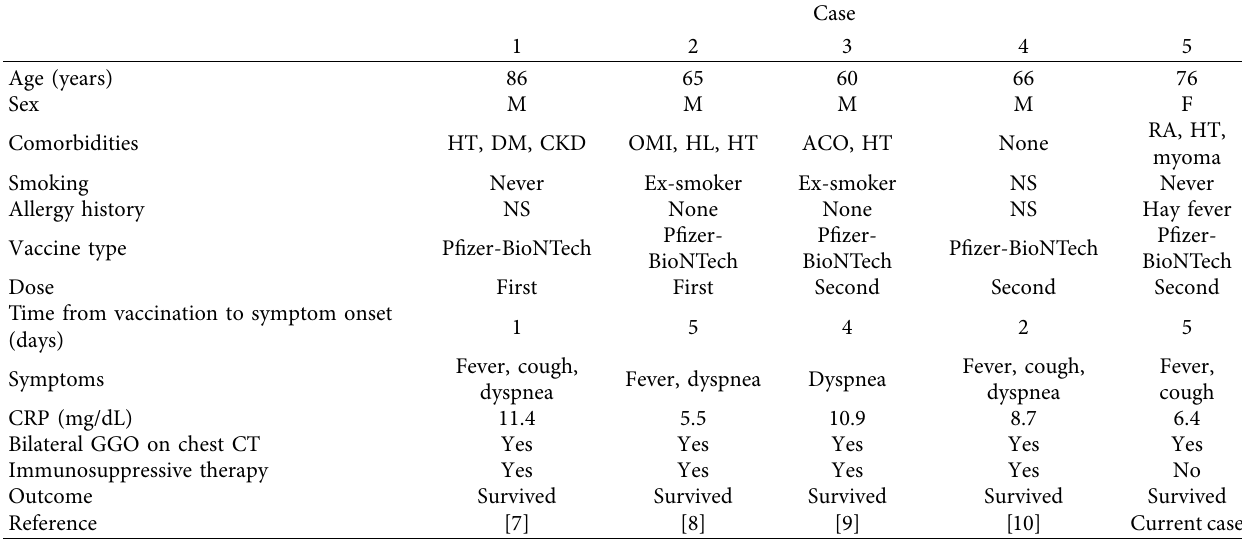
Table 1: Characteristics of patients with ILD after COVID-19